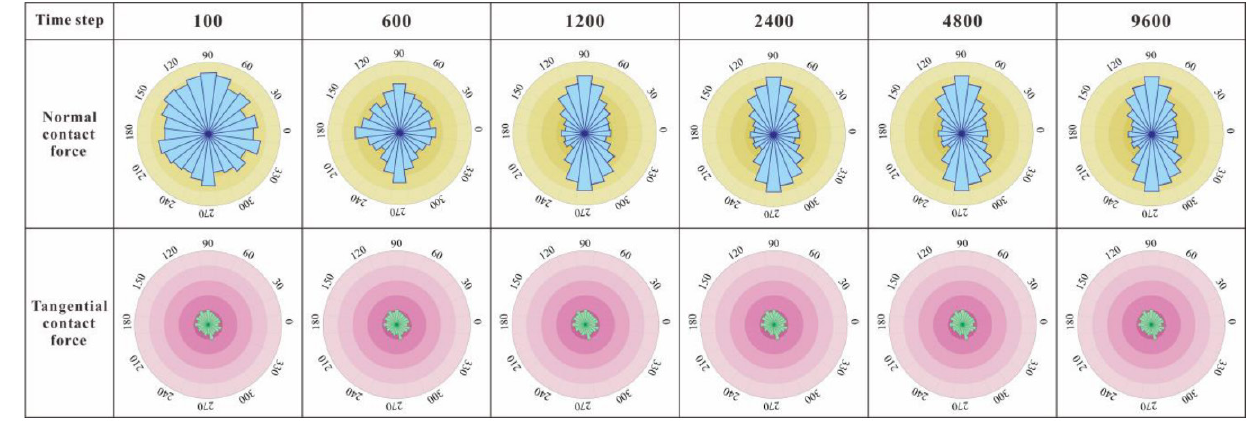
Figure 13. Evolution of the contact normal force and contact tangential force.